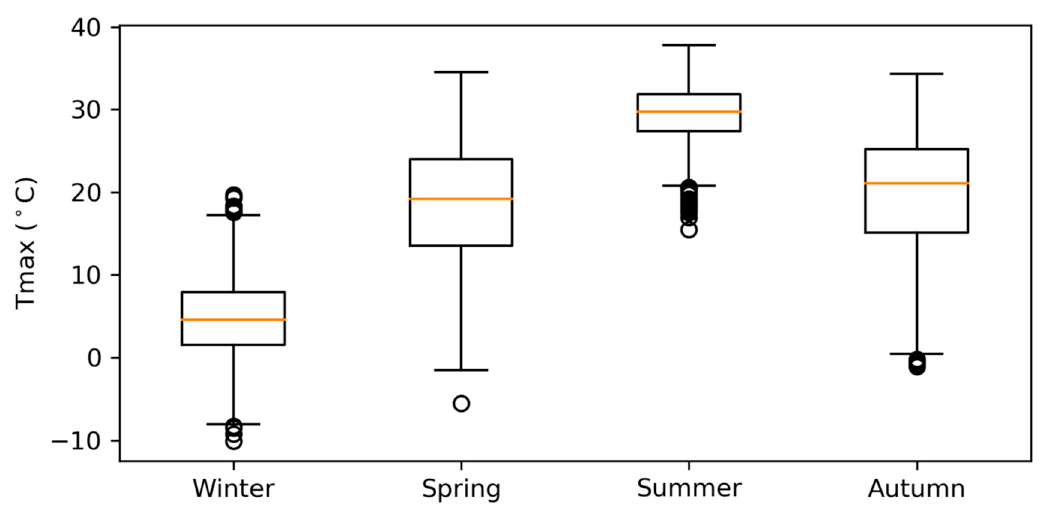
Figure 2. Boxplot of the daily maximum temperature for every season.